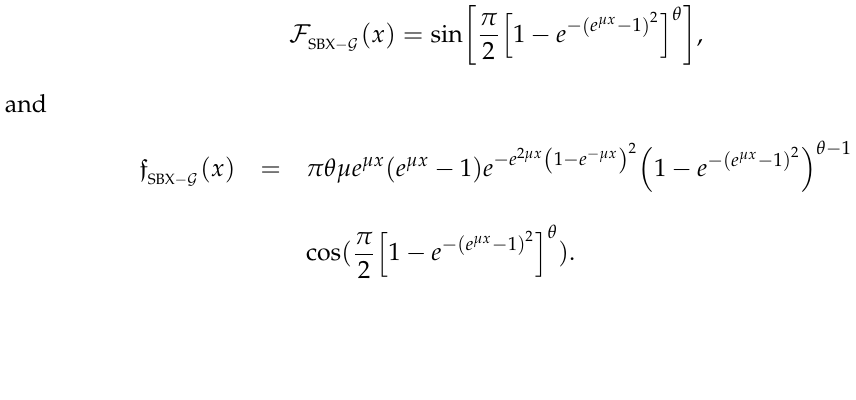
If G ( x ) = e µ x − 1 and g ( x ) = µ e − µ x , then the cdf and pdf of the SBXE model e µ x (for x > 0) are given